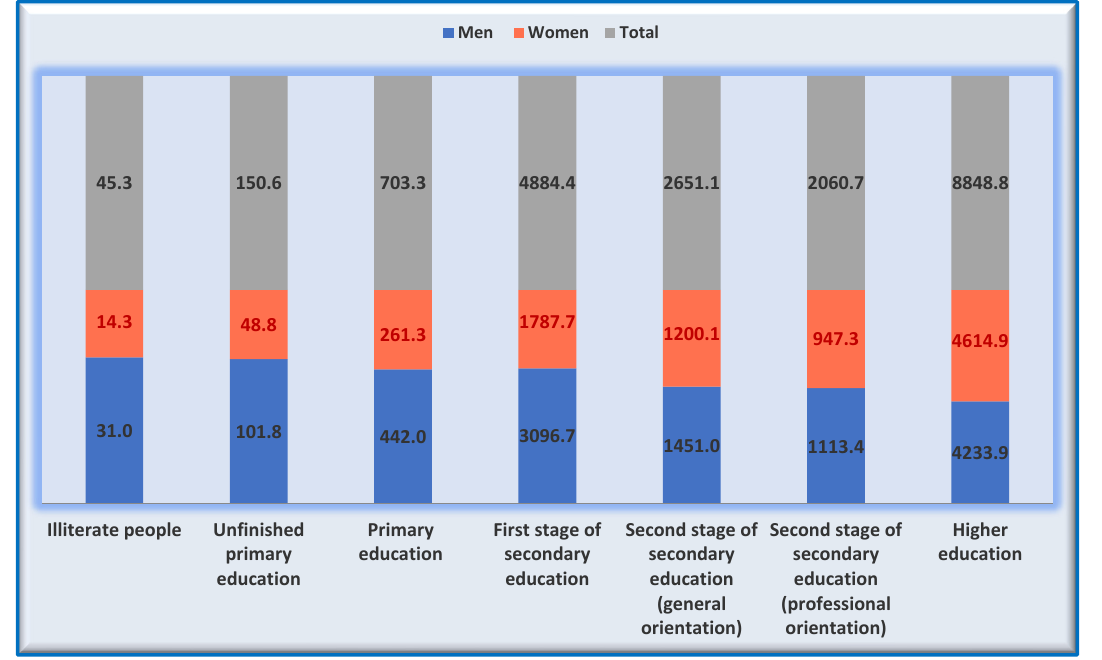
Figure 7. Employed persons by sex and educational level attained (in thousands). Source: Authors with data corresponding to the fourth quarter of 2020 provided by the Statistics National Institute ( Instituto Nacional de Estadística ).